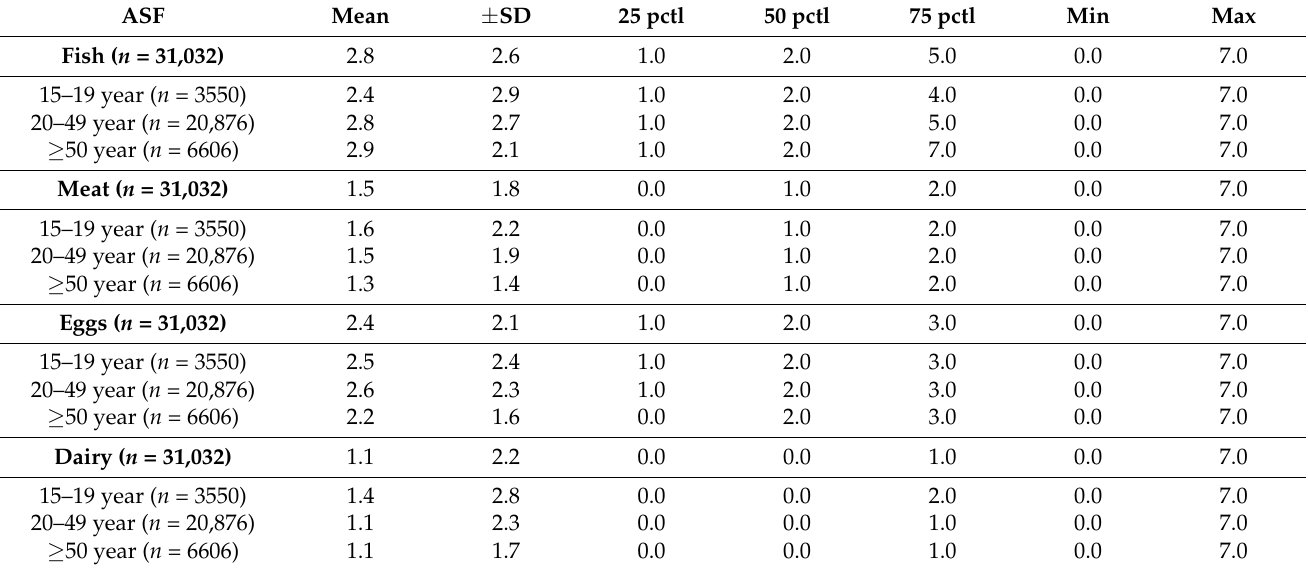
Table 4. Mean Consumption of animal source foods (ASF) in IFLS5 by